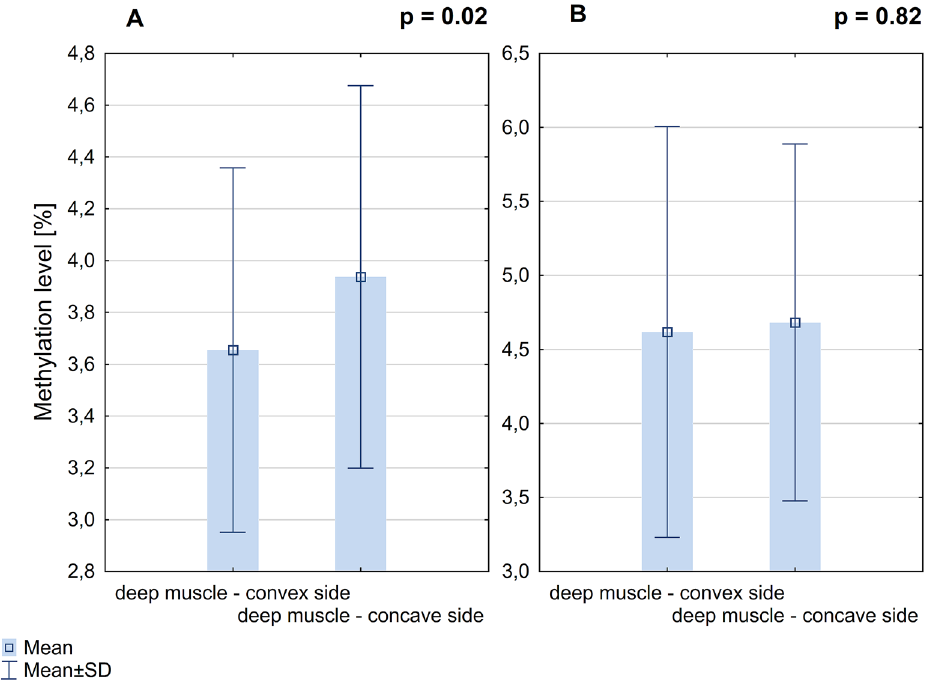
Figure 1. DNA methylation level within ESR2 promoter 0N ( A ) and exon 0N ( B ) in deep paravertebral